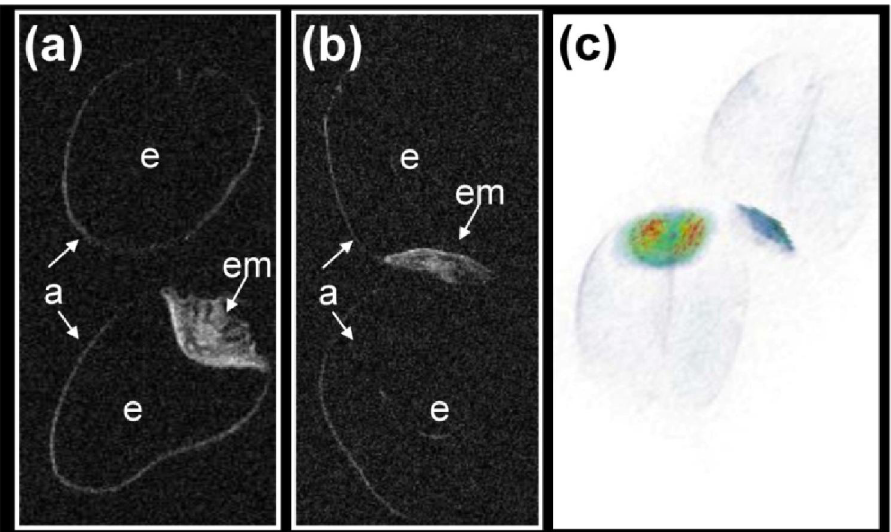
Figure 3. Quantitative NMR based imaging of lipids in living grains at the start (bottom) and end (top) of the artificial aging procedure. ( a , b ) Partial 3D representation of lipid distribution in the grain; ( c ) a lipid map showing the fall in embryo oil content in the aged grain (the red colour indicates the maximum lipid content). a: aleurone, e: endosperm, em: